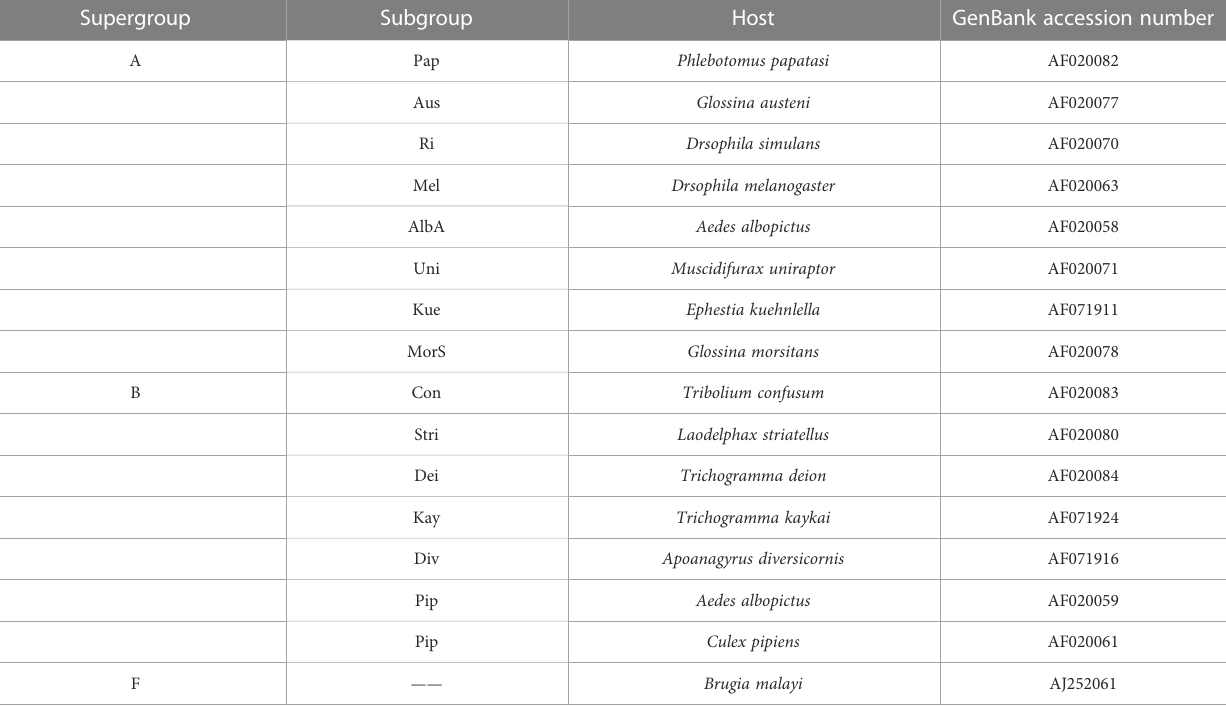
TABLE 3 The reference sequences of Wolbachia wsp genes used in the phylogenetic analysis.